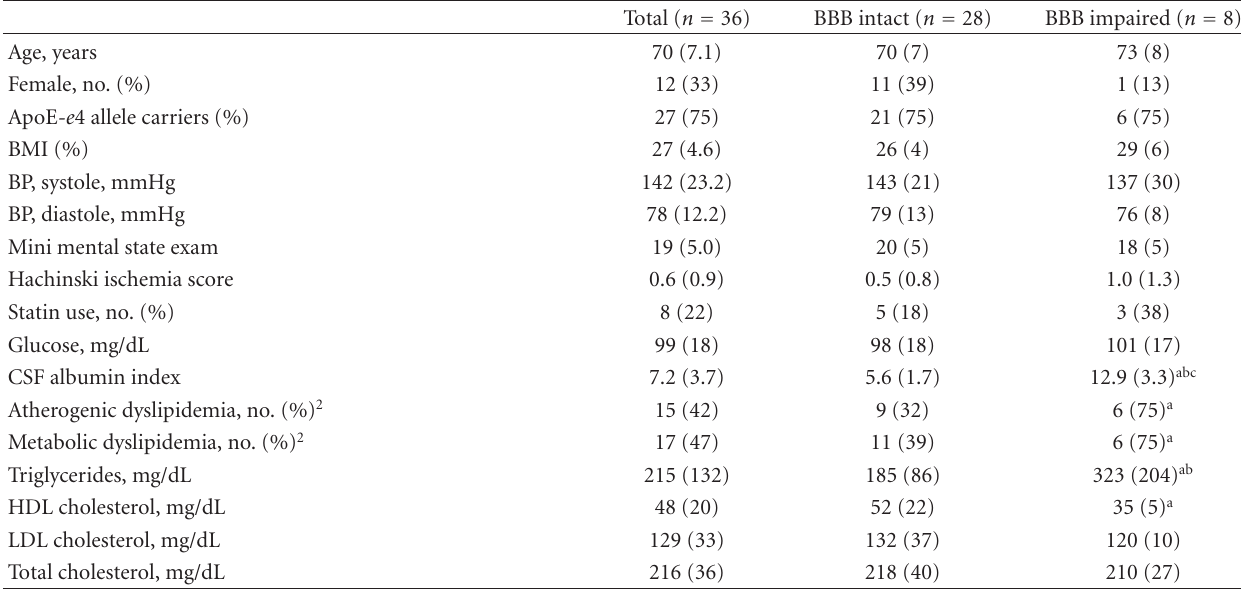
Table 1: Study population characteristics 1